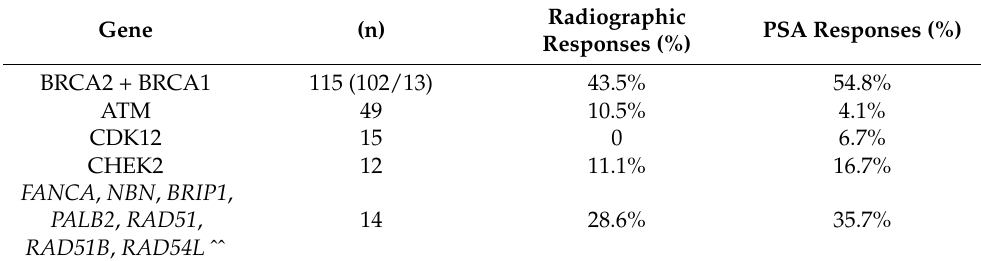
Table 6. TRITON2 Study.